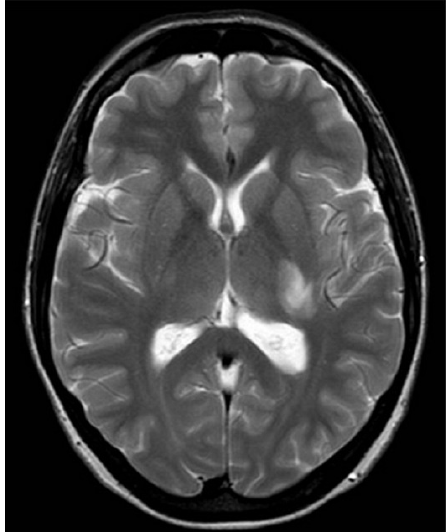
Figure 1. T2-weighted axial MRI.